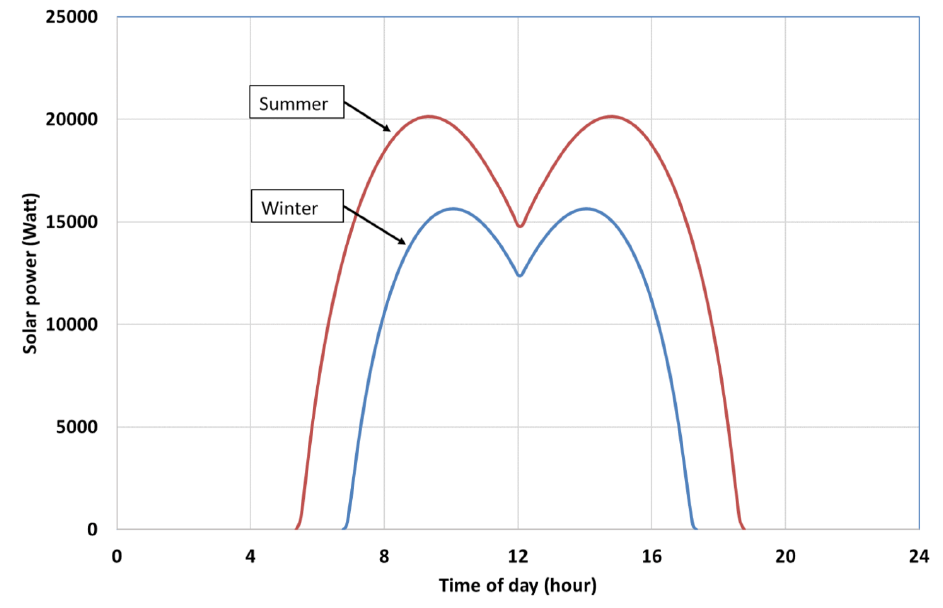
Figure 8. Total incident solar radiation on the container walls for mid-summer and mid-winter. The incident solar power on the walls of the steel container causes a temperature increase in the steel walls of the container, as shown in Figure 9.